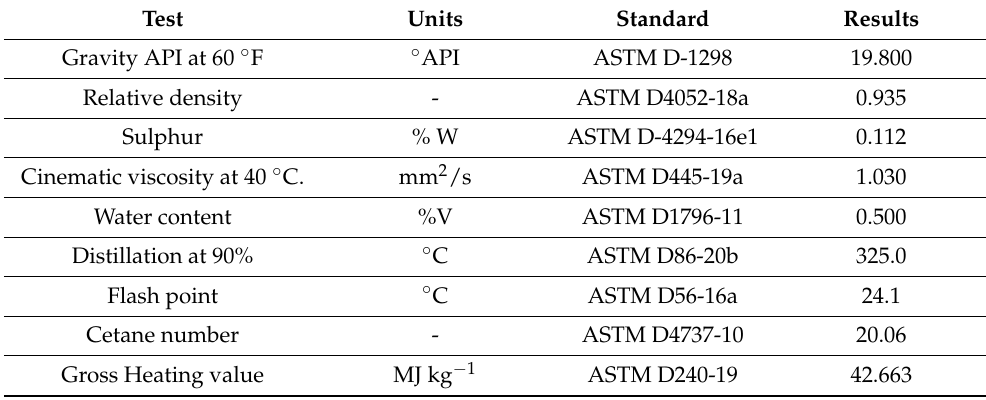
Table 3. Characteristics of the bio-oil obtained at 400 ◦ C.